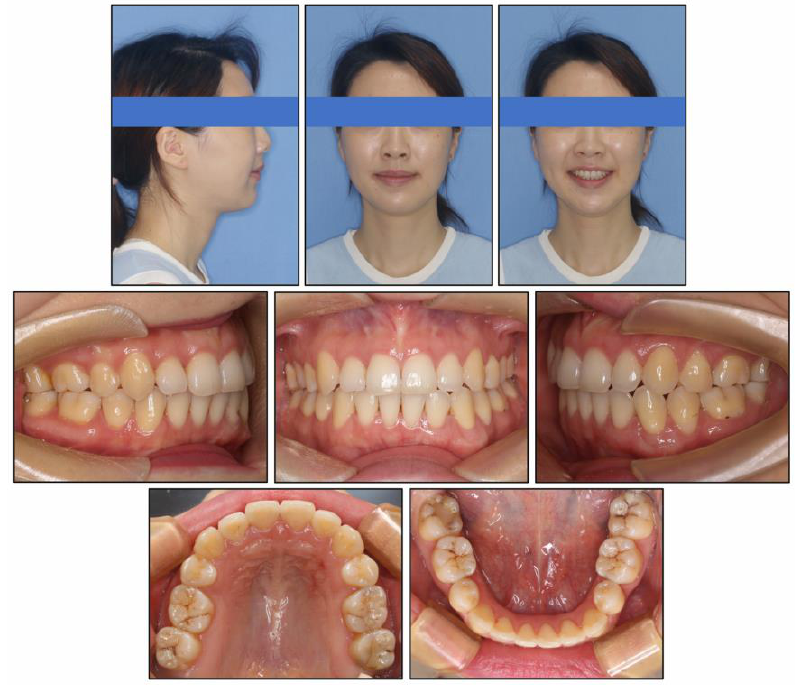
Figure 12. Follow-up intraoral and facial photographs at two years six